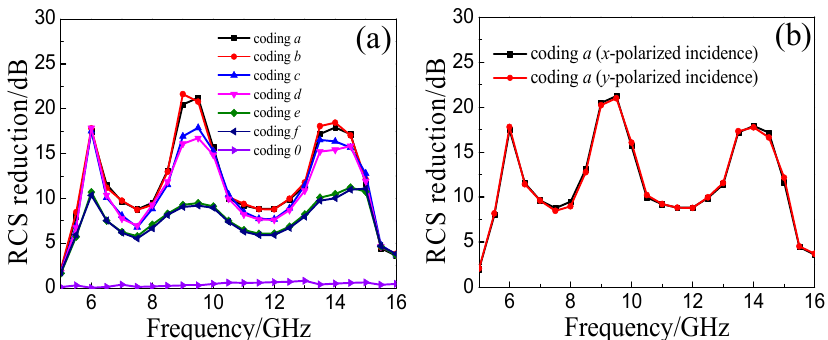
Figure 5. ( a ) RCS reduction of matrix-type random coding MS with different ratio combinations of “0” and “1” units; and ( b ) RCS reduction of coding a at x- and y- polarized wave incidence.